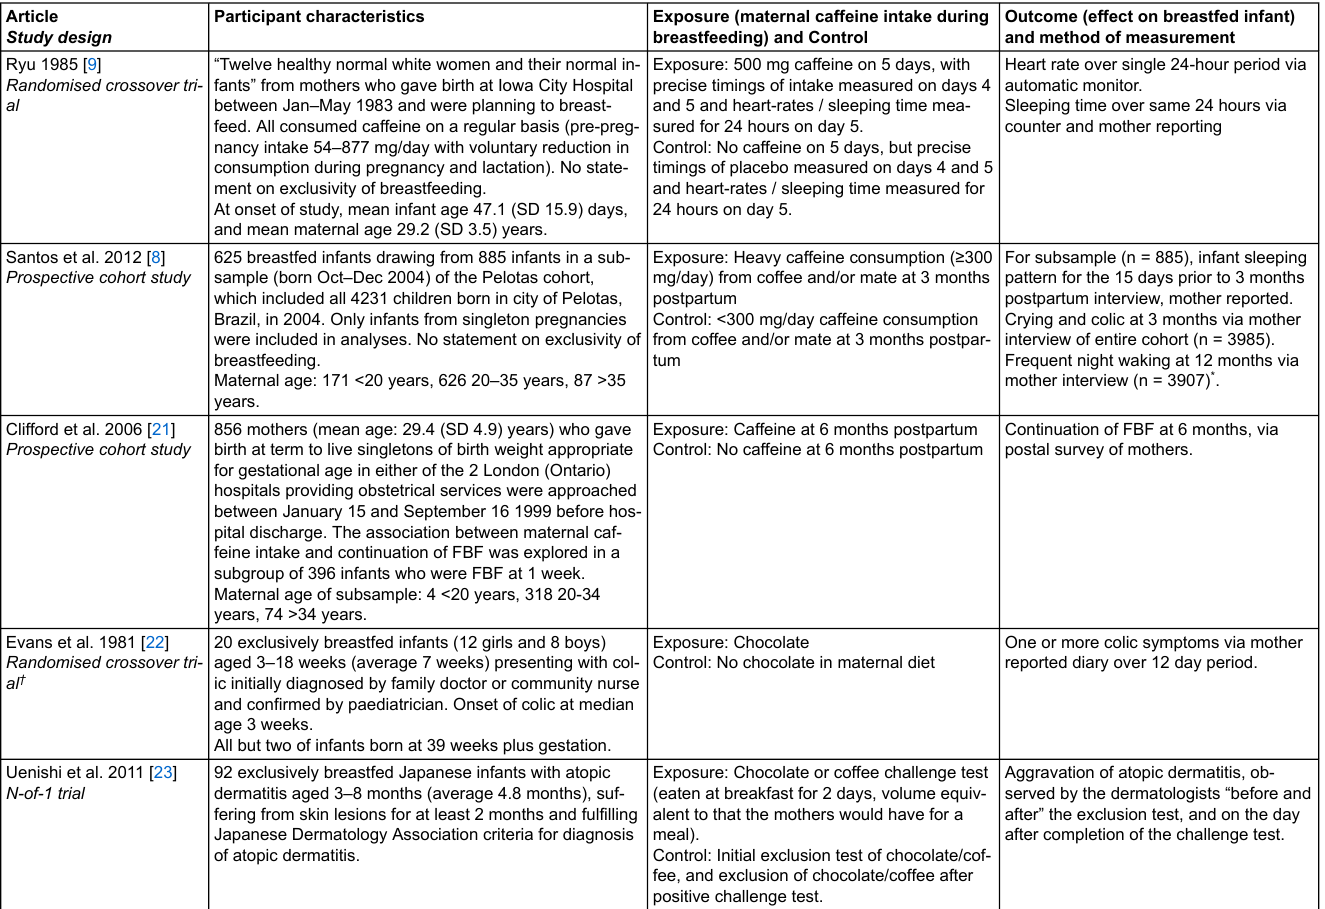
Table 1: Characteristics of included